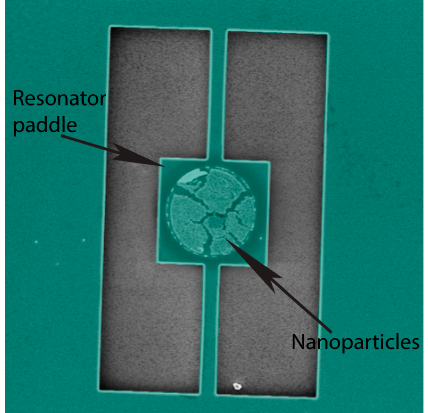
Figure 13. Nanoparticle circles on SOI by nanofabrication. The resonator paddle is 6 µ m